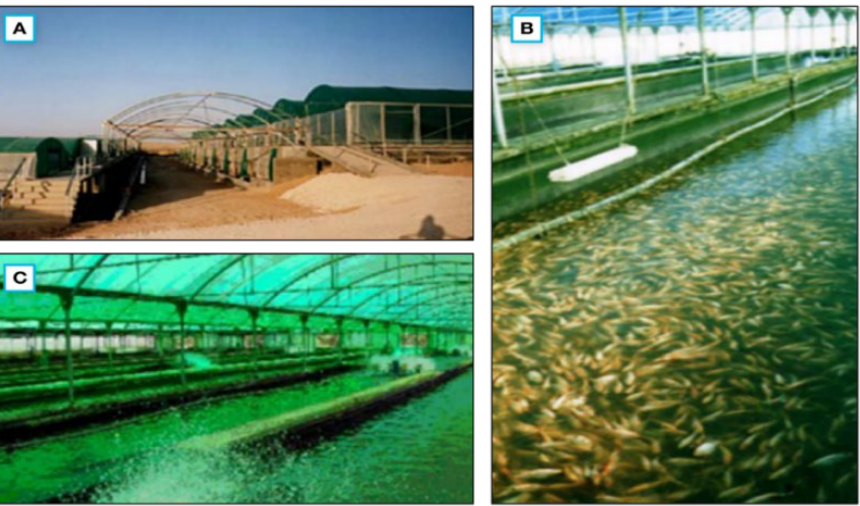
Figure 6. A typical fish farm named Re’em in the desert in Israel. ( A ) Fish farm; ( B ) raceway system; ( C ) high density of red tilapia in raceway system.